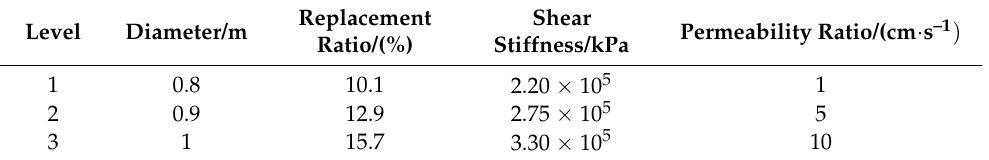
Table 1. Factors of orthogonal